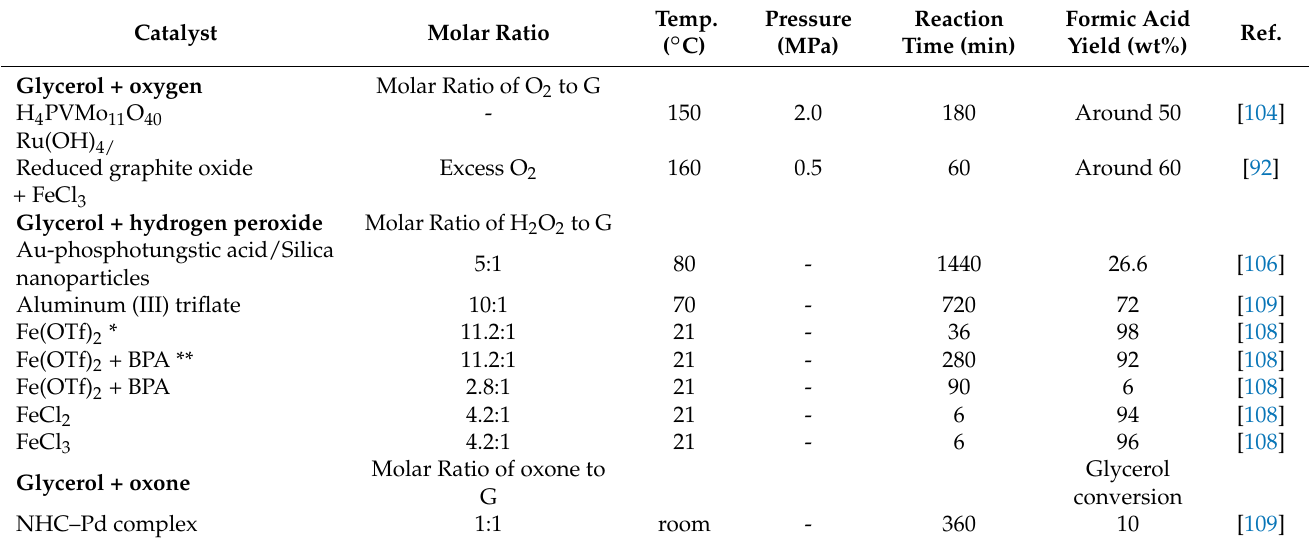
Table 2. Catalysts used for C 1 derivative by glycerol oxidation and the reaction conditions. Catalyst Molar Ratio